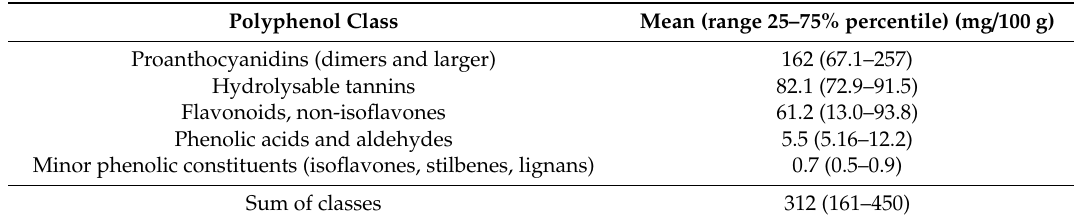
Table 2. Polyphenol composition of the almond (data from Bolling, 2017)